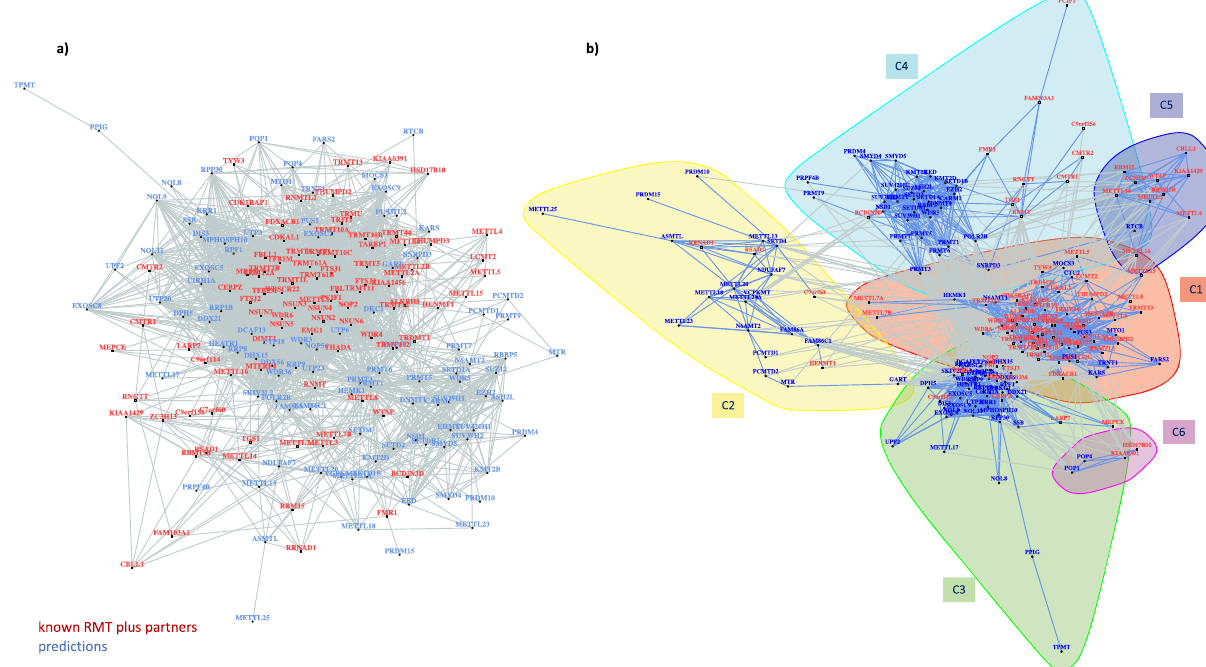
Fig. 5 PPI network of known and predicted genes involved in RNA pathways. a Network based on available PPI data connecting newly predicted genes with previously annotated RNA methyltransferases and associated proteins. b Subgroups of proteins associated with speci fi c pathways, as inferred using the Louvain method of community